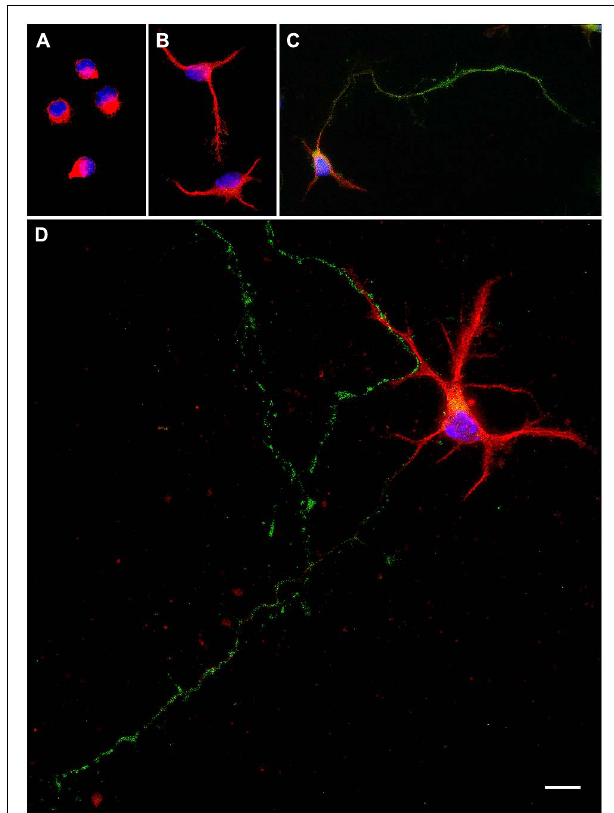
FIGURE 1 | Representative examples of primary hypothalamic neurons at different stages of development. (A) Stage I; (B) Stage II; (C) Stage III and (D) , Stage IV. In stage I neurites are not still emerged. Neurons in stage II show short neurites or minor processes. In stage III neurons show a thin, long andTau-positive neurite, relatively uniform in diameter, which corresponds to the axon. In stage IV dendrites showY angles branching. Scale bar, 10 μ